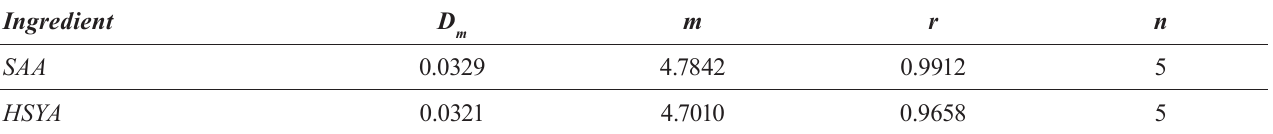
TABLE III - Dose-effect relationship parameters of various agents against the growth of rat brain microvascular endothelial cells in vitro *